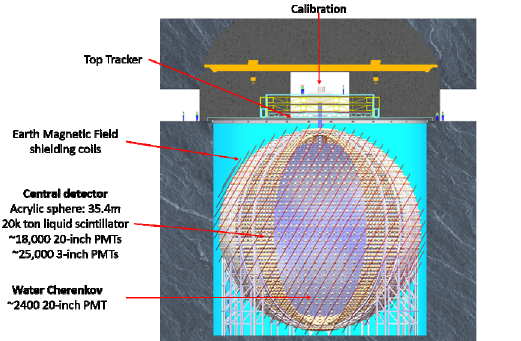
Fig. 1. Schematic of some of the main parts of the JUNO detector, consisting of a 35.4m diameter sphere filled with 20 ktons of liquid scintillator surrounded by around 43,000 PMTs and immersed in ultrapure water.